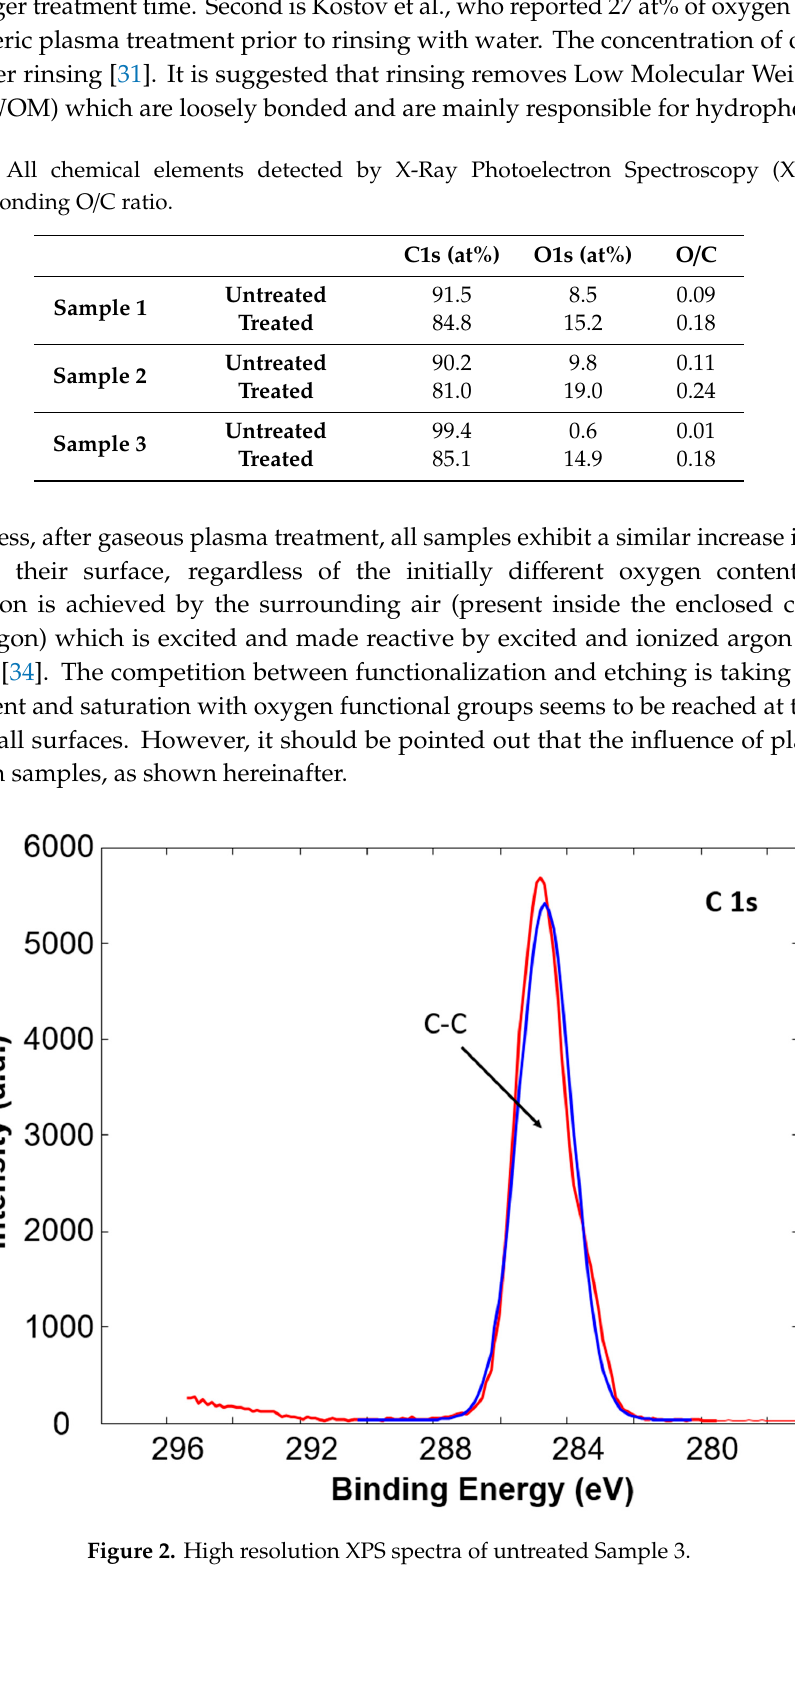
Figure 3. High resolution XPS spectra of plasma treated Sample 3.